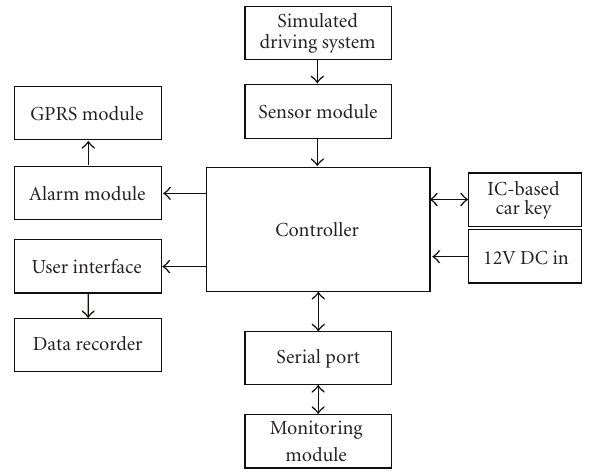
Figure 2: Architecture of the system hardware